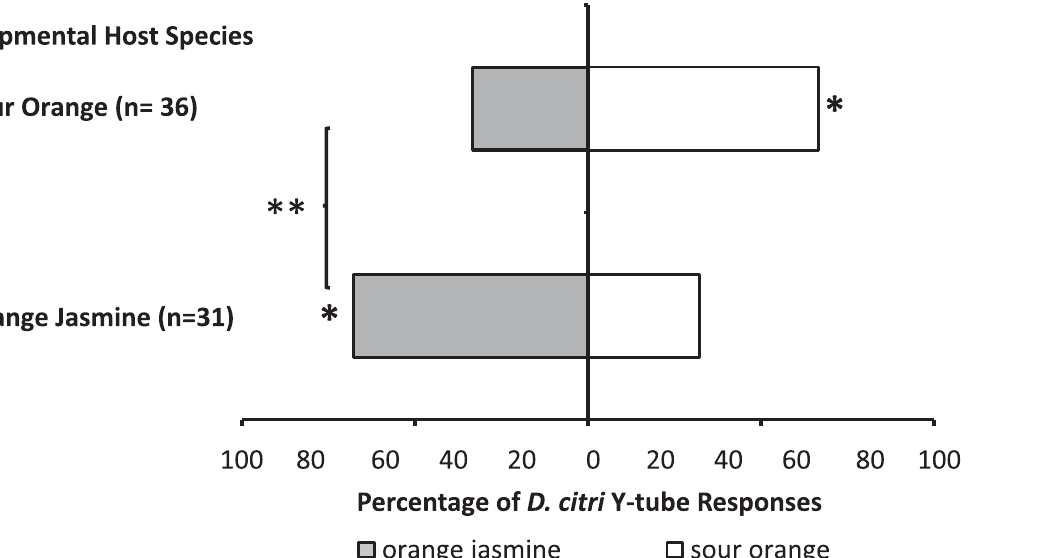
Fig 2. Developmental host plant preference. Differences in female D . citri preference based on natal host plant species. Asterisks within bars indicate statistically significant differences within groups, while asterisks associated with a bracket indicate differences between groups ( χ 2 test, * : < 0.05, ** : < 0.01).